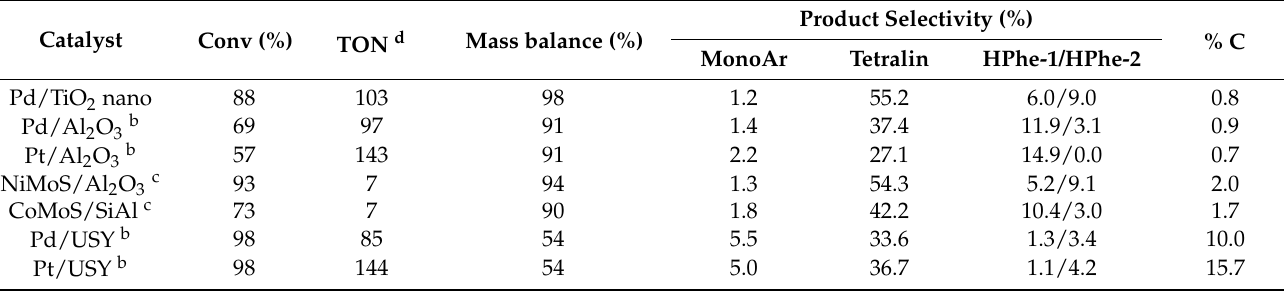
a Reaction conditions: 0.5 g of tars-type compounds, 4 g of n-hexadecane, at 275 ◦ C and 30 bar of H catalysts, metal content ≈ 1.0 wt%, except for Pd/TiO 2 nano (1.3 wt%). c In NiMoS/Al 2 O 3 Ni content = 3.3 wt% and Mo content = 12.0 wt%; and in CoMoS/SiO 2 -Al 2 O 3 , Co content = 2.8 wt%; and Mo content = 8.0 wt%. d TON = mols of products/mols of Metal in catalyst.